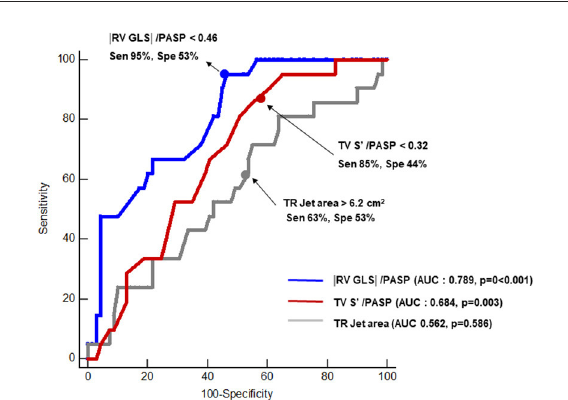
FIGURE3 Receiver operating characteristic analysis comparing predictive values of tricuspid annular S’ /PASP, |RV GLS|/PASP and TR jet area for predicting persistent TR after closure of ASD. AUC, area under the curve; Sen, sensitivity; Spe, specificity; RV GLS, right ventricular global longitudinal strain; PASP, pulmonary arterial systolic pressure; TR, tricuspid